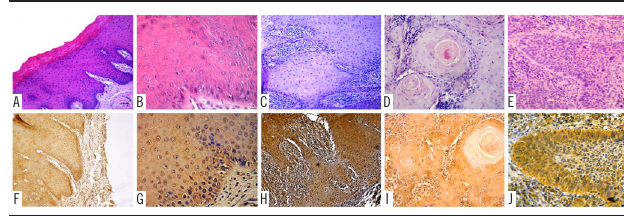
Figura 4: Fotomicrografias de Leucoplasias e de CCEs orais em coloração HE (A-E) e imunomarcadas para TIMP-1 (F-J). FIGURE 4 – Photomicrographs of leukoplakia and oral SCCs in HE staining (A-E) e and Leucoplasia leve (A e F). Leucoplasia moderada (B e G). Leucoplasia severa (C e H). CCE Grau I (D e I). CCE Grau II (E e immunolabeleing for TIMP-1 J). Barra de escala = 20  Mild leukoplakia (A and F); moderate leukoplakia (B and G); severe leukoplakia (C and H); stage I SCC (D and I); stage II SCC (E and J); scale bar = 20 µm. SCC: squamous cell carcinoma; HE: hematoxylin and eosin; TIMP-1: tissue inhibitor of metalloproteinase-1.